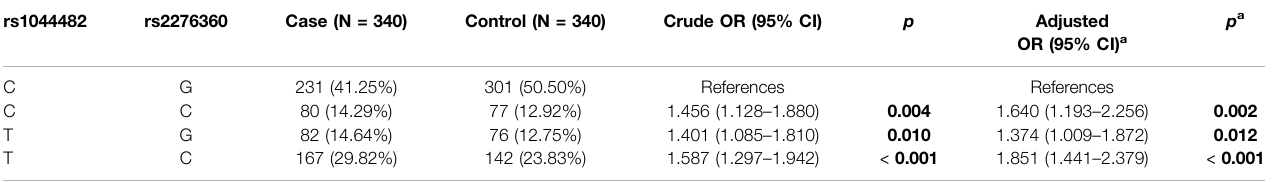
TABLE 5 | The frequency of inferred haplotypes of the two SNPs based on observed genotypes and their association with the risk of